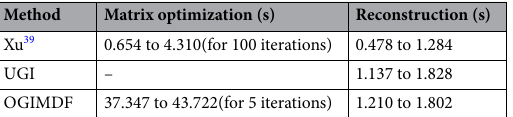
Table 2. Running time of three methods in terms of matrix optimization and image